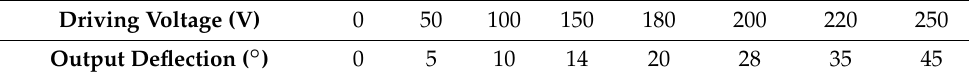
Figure 9. Reverse-biased drive test of deformed squama. Table 3. The actual scale angle corresponding to the given reverse - biased driving voltage. Driving Voltage (V)